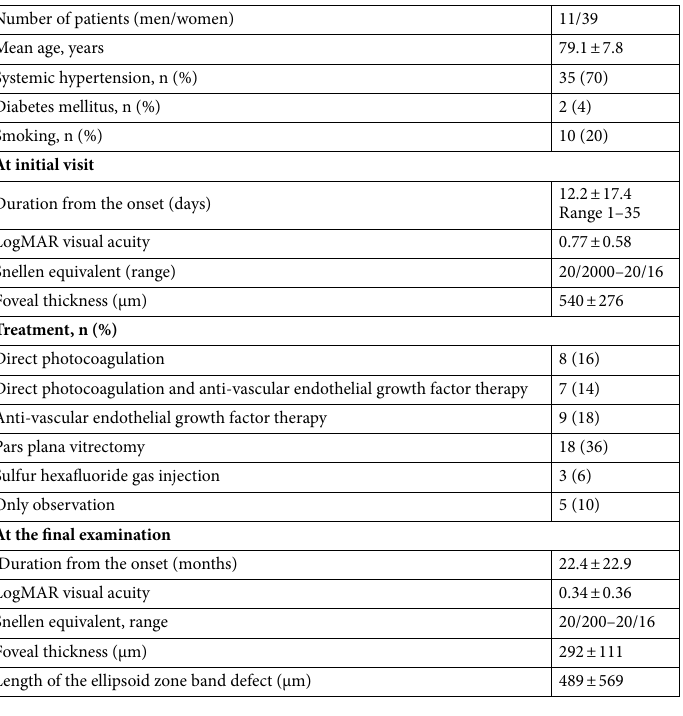
Table 1. Characteristics of patients with ruptured retinal macroaneurysms. LogMAR = logarithm of the minimal angle of resolution. Data are expressed as mean ± standard deviation unless otherwise